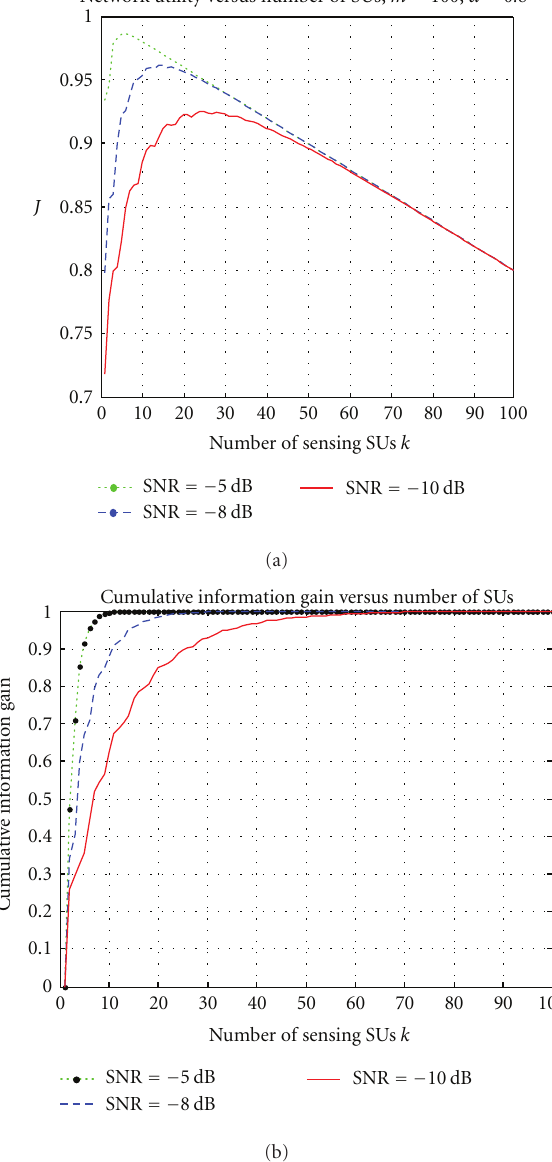
Figure 3: Network utility function J and cumulative information gain versus k for di ff erent